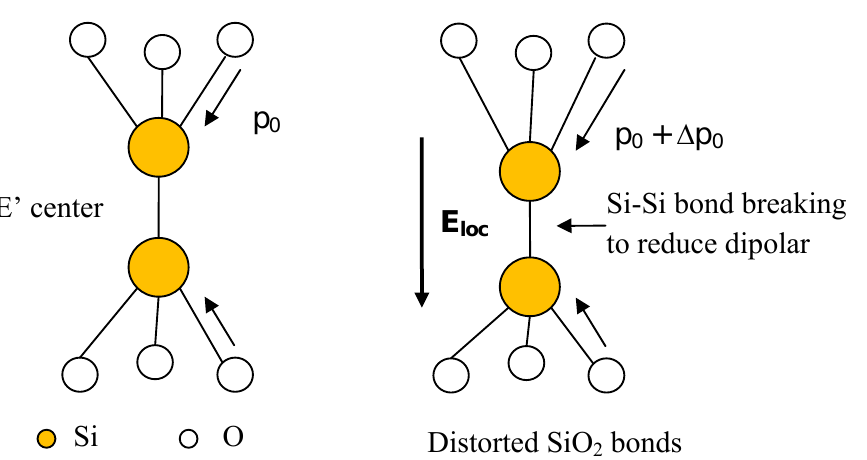
Figure 4. Schematic diagram of the Si-Si bond breaking process of the E’ center in SiO under voltage stress. Each Si-O bond has a permanent dipole moment p distorts the Si-O bonds in the O the Si-Si